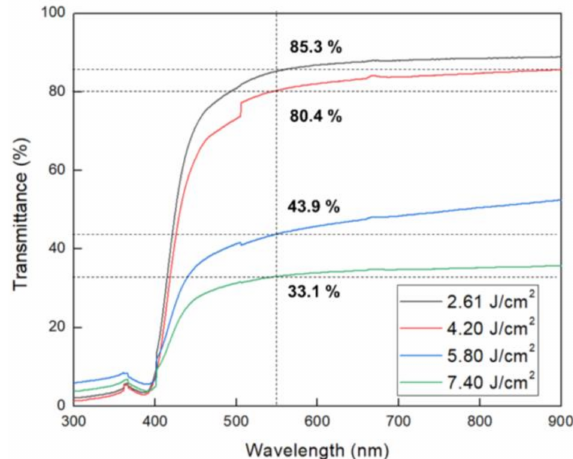
Figure 7. Variation of the obtained transmittance with XFL energy.